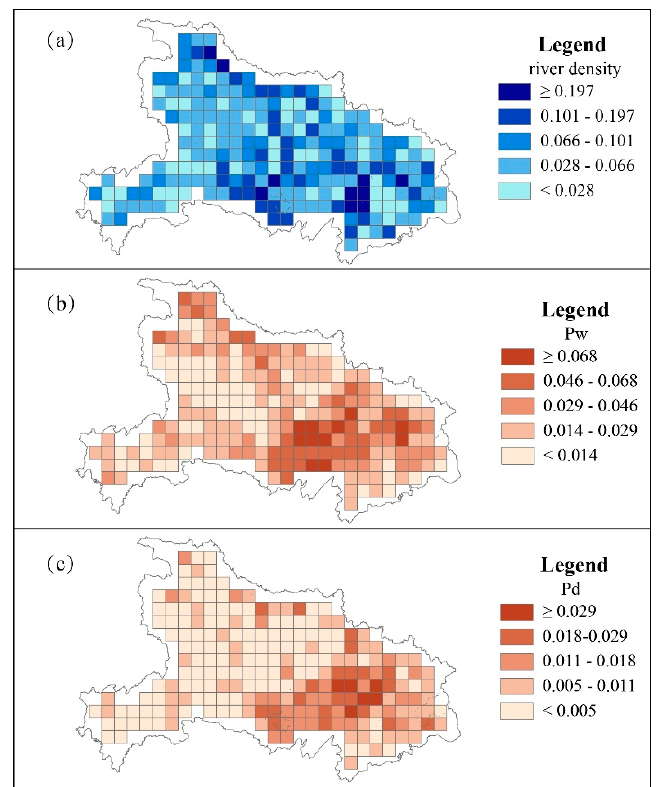
Figure 3. Choropleth maps of P w , P d , and D w at the unit level, ( a ) Choropleth map of the river network density at unit level; ( b ) Choropleth maps of P w at the unit level; ( c ) Choropleth maps of P d at the unit level.